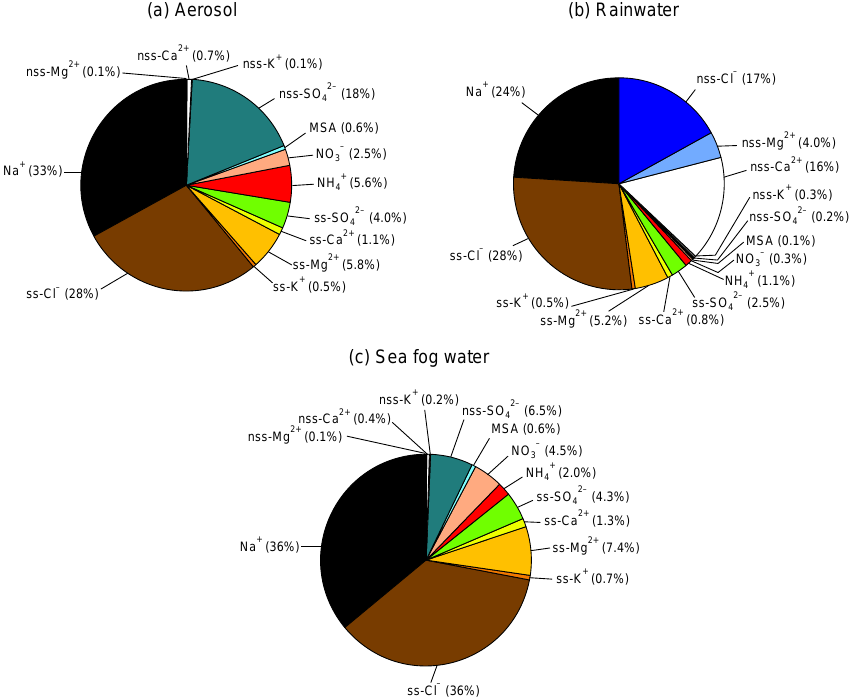
Fig. 4. Mean contributions of each major ionic component to total ionic concentration in (a) aerosols ( n = 11), (b) rainwater ( n = 7), and (c) sea fog water ( n = 15) collected over the subarctic western North Pacific Ocean during the cruise. Table 2. Mole equivalent ratios for major ionic species in aerosols, rainwater, and sea fog water, together with seawater ratios for comparison a . Aerosol Sea